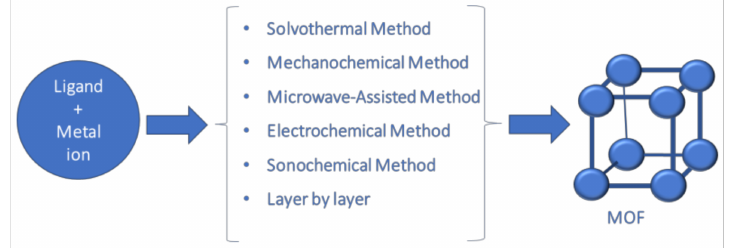
Figure 1. Schematic representation of MOFs